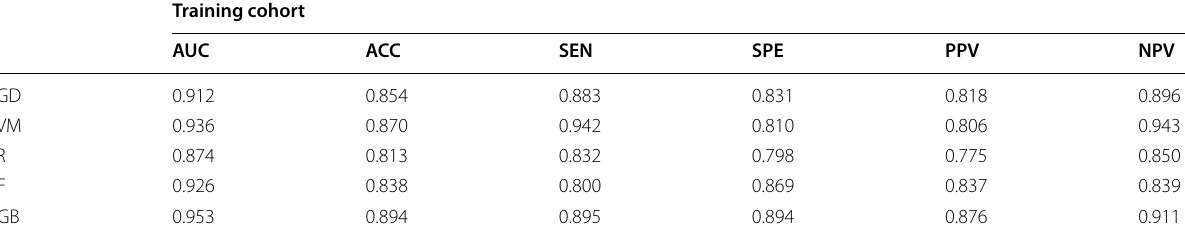
HT, hemorrhagic transformation; SGD, Stochastic Gradient Descent; SVM, Support Vector Machine; LR, Logistic Regression; RF, Random Forest; XGB, eXtreme Gradient Boosting; AUC, area under the receiver operator characteristic curve; ACC, accuracy; SEN, sensitivity; SPE, specificity; PPV, positive predictive value; NPV, negative predictive